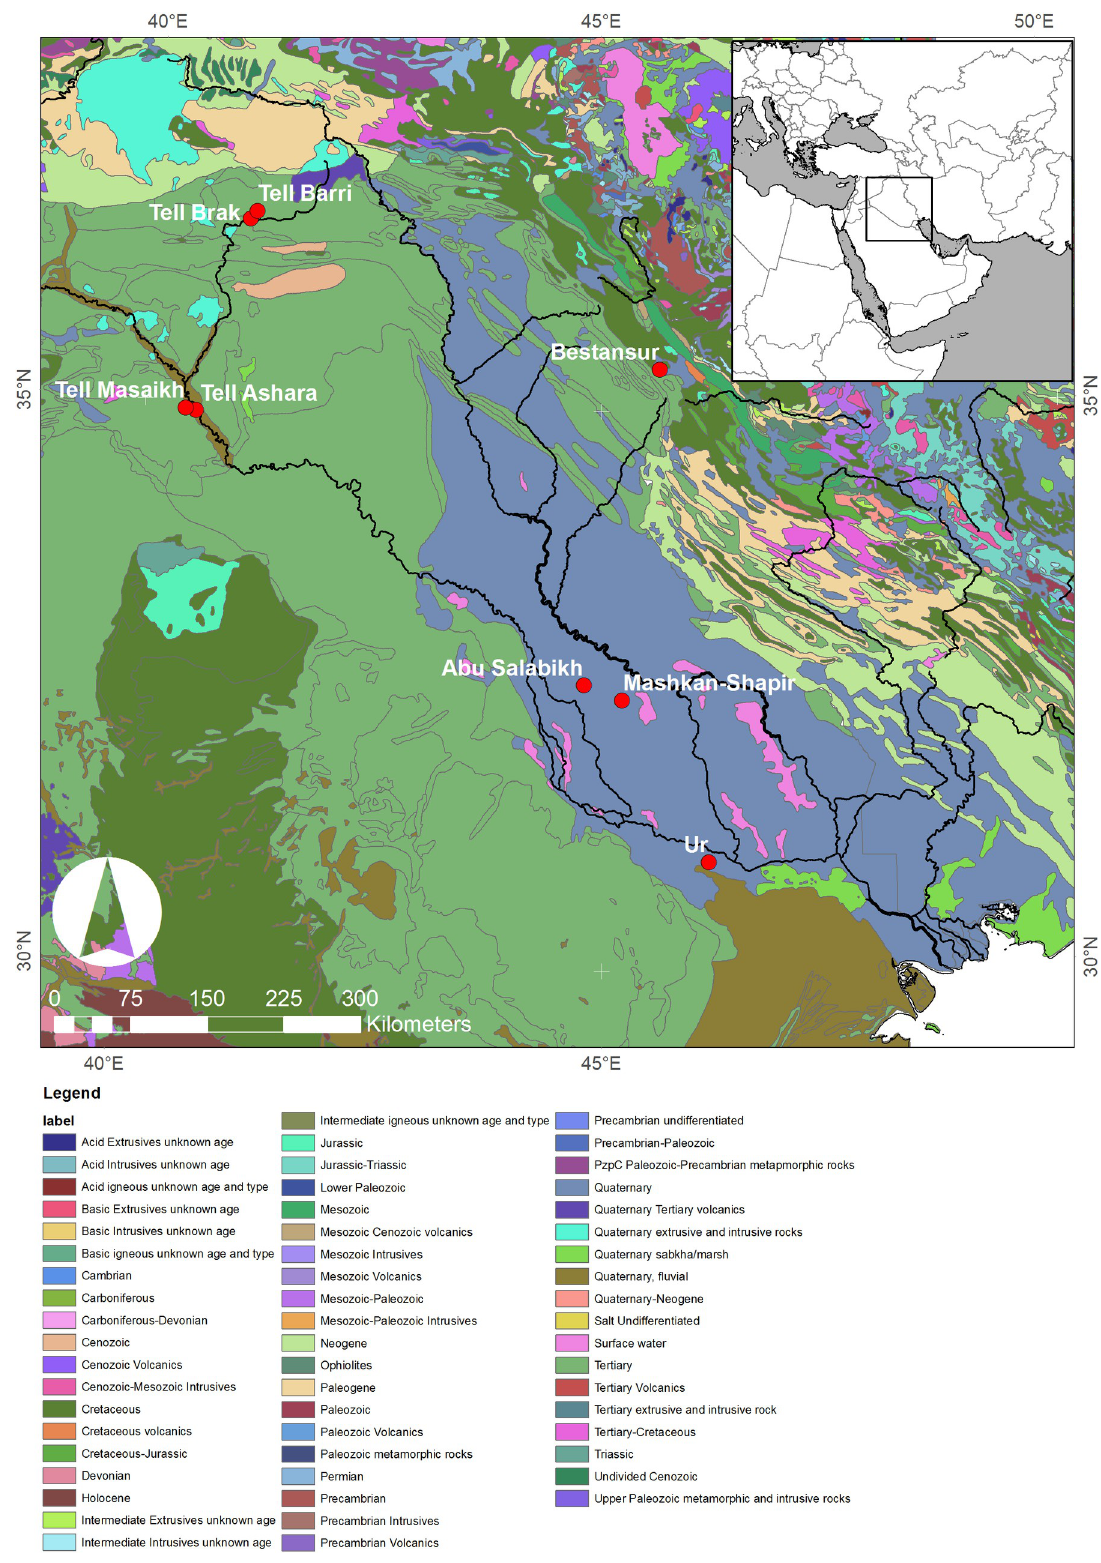
Fig 3. Map showing the geological substrate of Iraq and the location of sites mentioned in the text. World Geologic Map data for the Arabian Peninsula and Iran courtesy of the U.S. Geological Survey. Map composed by C.A. Petrie.